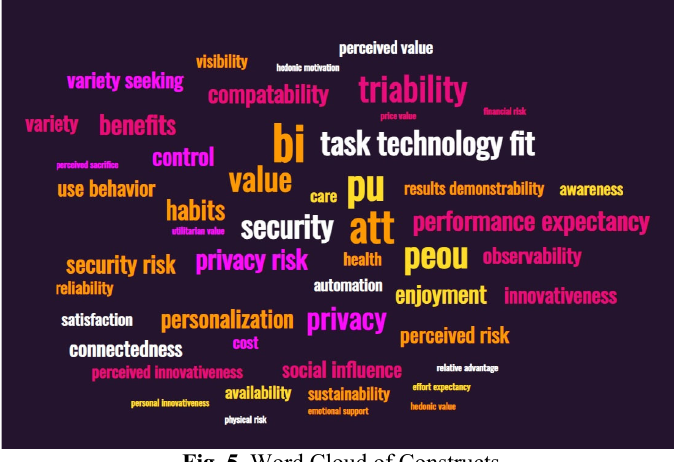
Fig. 5. Word Cloud of Constructs